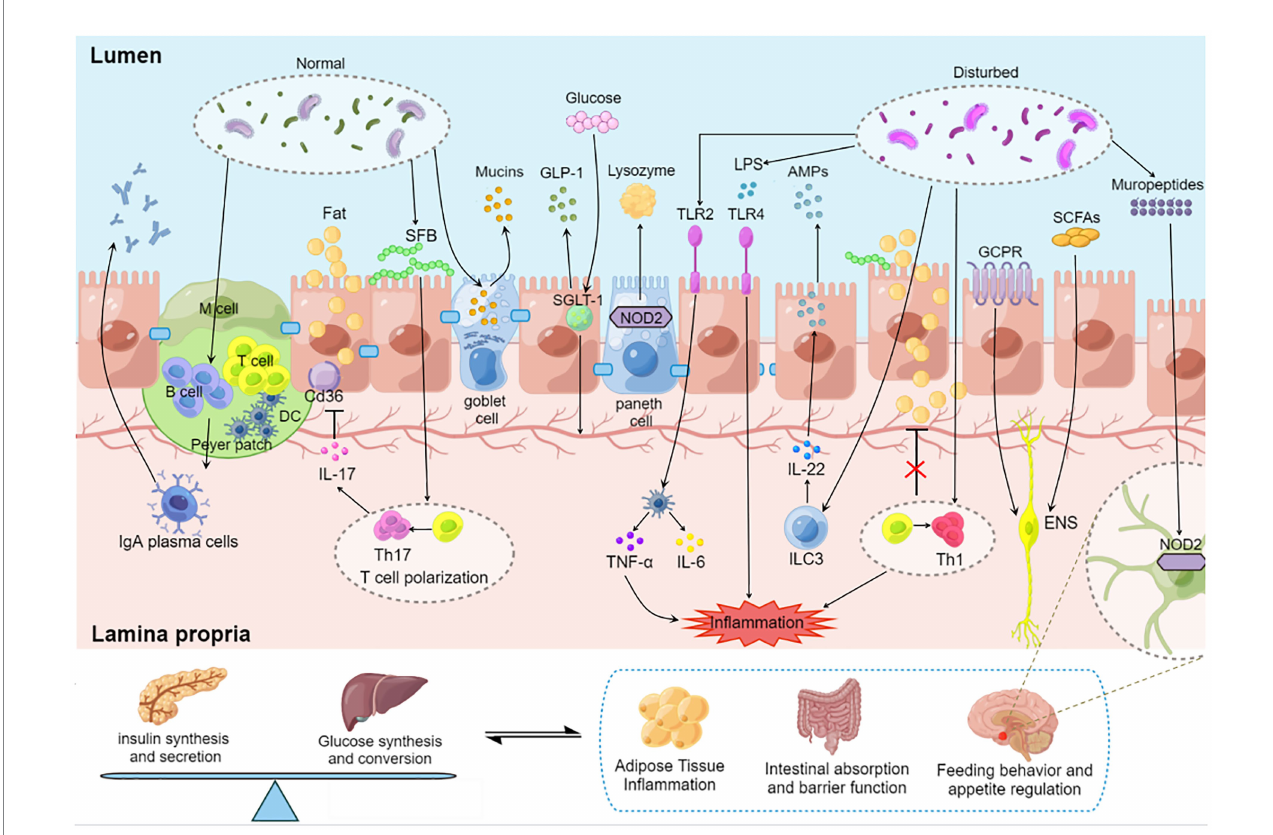
FIGURE 1 Regulation of blood glucose by gut microbiota–immunity interaction. Gut microbiota induces the maturation of gastrointestinal lymphoid tissue. Gut microbiota stimulates goblet cells to secrete mucin to protect the gut. Oligosaccharides produced by the gut microbiota bind to NOD2 receptors in Paneth cells and promote lysozyme release. SGLT-1 is influenced by the gut microbiota and regulates the balance between glucose uptake and GLP-1 release. SFB induced a Th17 response with elevated IL-17 levels, and IL-17 secreted by Th17 reduces lipid uptake and absorption by inhibiting the expression of Cd36 in epithelial cells. AKK activates TLR2 and induces dendritic cells to secrete inflammatory factors TNF- α and IL-6. Microorganisms affect the development of T cell subsets. Dysregulated microbiota release LPS to destroy the intestinal barrier, stimulate epithelial cells to release AMP through TLR4 and aggravate intestinal inflammation. SCFAs promote insulin secretion through the vagus nerve. GPCR transmits fat signals to the brain to influence feeding behavior. Mural peptides produced by gut microbes act on Nod2 receptors in GABA neurons in the hypothalamus via the brain-gut axis to influence appetite and metabolism. DC, dendritic cell; SFB, segmented filamentous bacteria; SGLT-1, sodium-glucose cotransporter 1; GLP-1, glucagon-like protein 1; SCFA, short chain fatty acids; GCPR, G protein-coupled receptor; ILC, native lymphocyte; TLR, Toll-like receptor; LPS, lipopolysaccharide; ENS, Enteric nervous